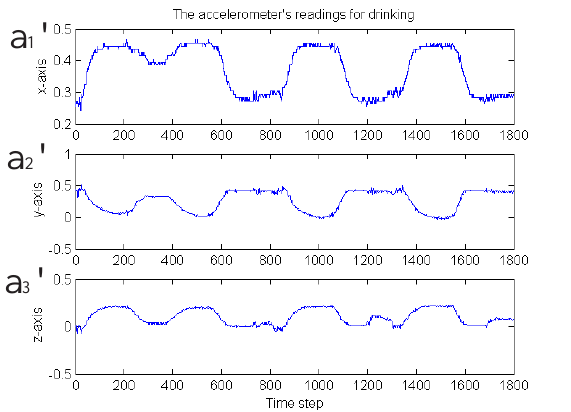
Figure 9. The raw sensor data from the 3 axis accelerometer of drinking